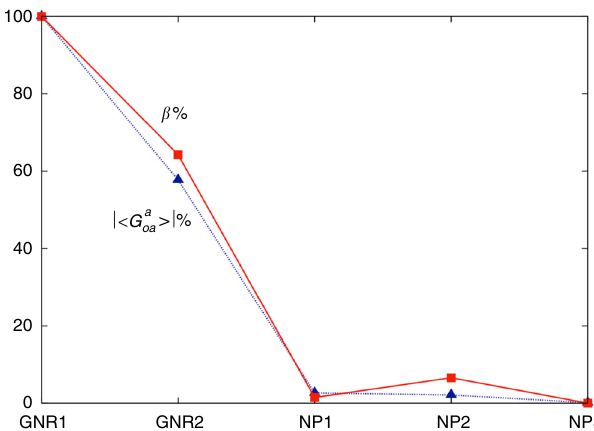
(cid:4) (cid:2) (cid:3)(cid:4) (cid:4) (cid:4) for the Au NPs oa